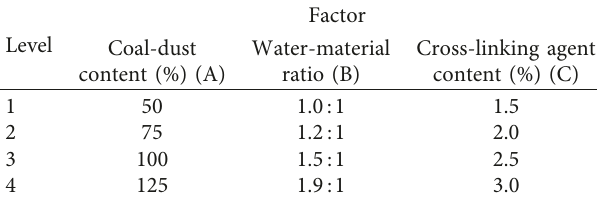
Table 1: Values of factors and levels.